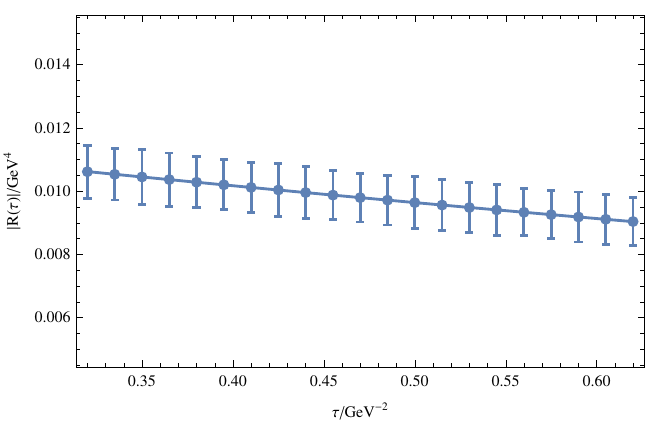
Figure 5 . QCDSR minimum- (cid:31) 2 (cid:12)t for the (cid:22) qq -hybrid mixed state: the dots represent the QCD side of the master equation (2.9), and the middle line represents phenomenological side of (2.9). The error bars are induced by 10% uncertainty of the phenomenological parameters of table 1.